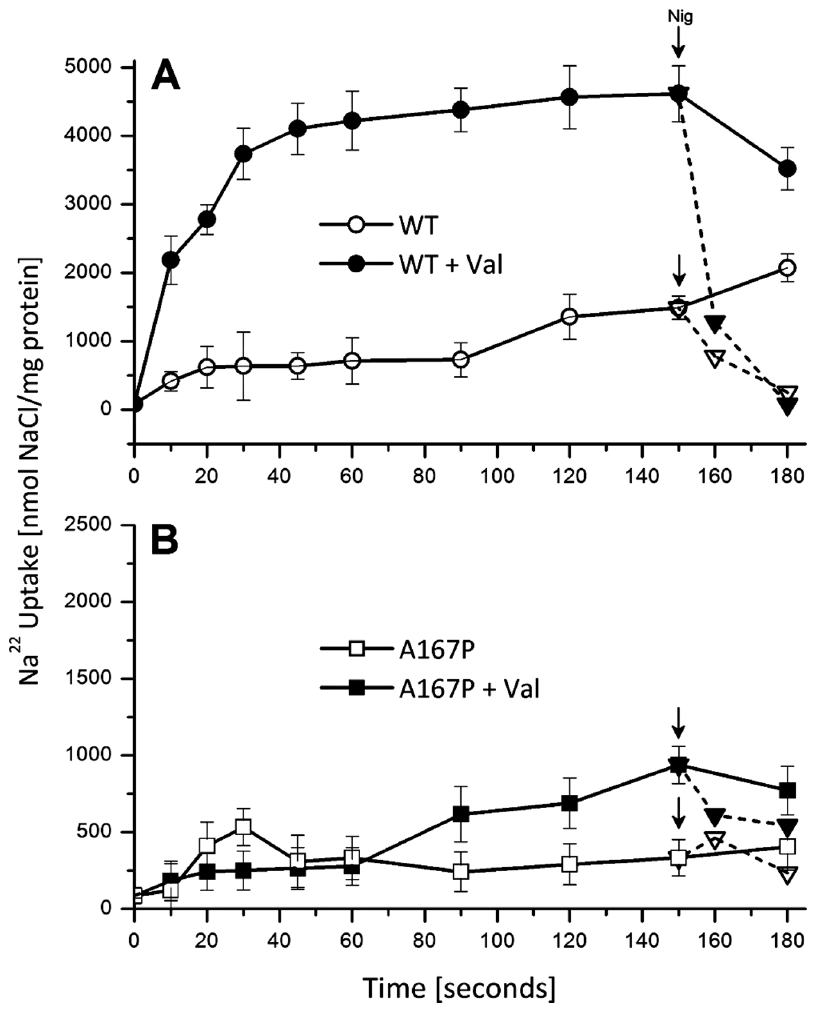
Figure 4. The effect of a counter-ion on 22 Na transport by A167P proteoliposomes. The affinity purified proteins of WT (A) and A167P (B) proteins were reconstituted into proteoliposomes and D pH (acidic inside)-driven 22 Na uptake was determined as described under ‘‘Experimental Procedures’’. The reaction mixture (500 m l) contained 150 mM choline chloride, 10 mM Tris/Hepes (pH 8.6), 2 mM MgS0 4 , 10 mM KCl and 50 m M 22 NaCl (1 m C/ml). Where indicated (filled symbols), valinomycin (5 m M) was added from zero-time. At steady state nigericin (1 m M) was added to the various reaction mixtures (dashed line).